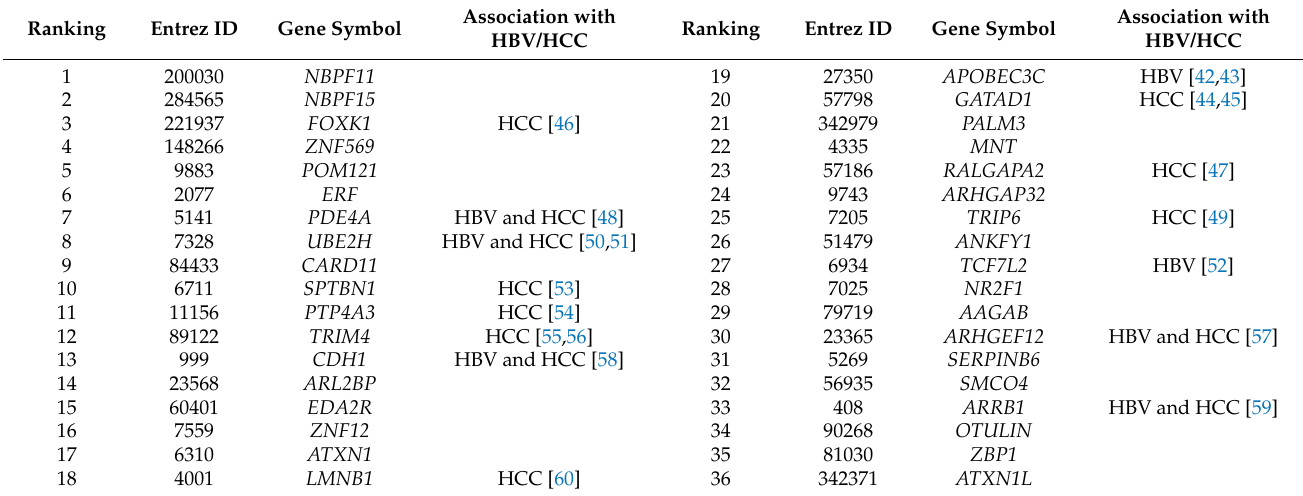
Figure 3. The 36 overlapping candidate genes are the intersection of the random walk with restart (RWR) and support vector machine (SVM) candidate genes. Table 2. The ranked gene list of potential conditionally essential genes.